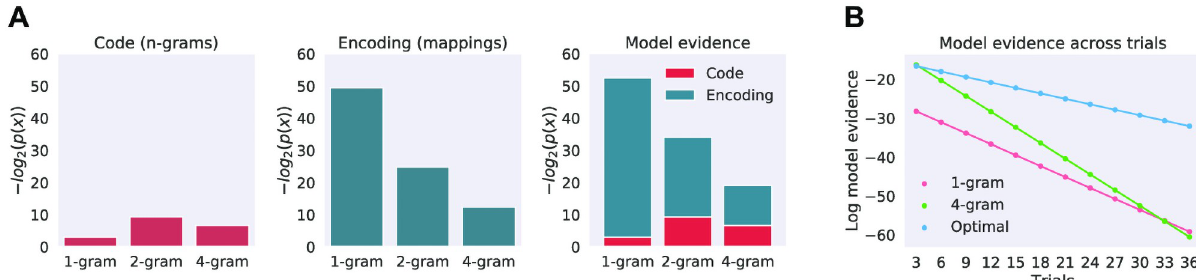
Fig 8. Optimal chunking model. (A) Evidence for three alternative chunking models and their components at the beginning of the scanning experiment, when participants had seen the two repeating sequences 12 times each during the practice session. The three models use only single type n- grams: the 1-gram model encodes sequences using four single-item n-grams, 2-gram model with two bi-grams, and the 4-gram model with a single four-gram. The left panel shows the probability of the set of n-grams (code) each model specifies in terms of their negative log values. The centre panel shows the probability of their mappings (encoding) and the right panel the combination of the two into model evidence. The blue and red parts of the model evidence bar represent model code (n-grams) and encoding (mappings) probabilities in terms of their negative logs and the total length of the bar displays the model evidence as their sum. This allows intuitive visualisation of the code-encoding trade-off calculated by the Bayesian model comparison. The 4-gram model is the optimal model at the start of the experiment. (B) Model evidence across trials. X-axis shows the trial number and y-axis shows the log of model evidence. The optimal model is inferred at every trial; the 1-gram model encodes sequences only with four uni-grams, and the 4-gram model only uses four-grams. Note that at the beginning of the experiment the 4-gram model is equivalent to the optimal model: however, as new sequences are presented the optimal model encodes new data with shorter chunks (uni-grams) while the 4-gram model encodes new unique sequences with four-grams. Note that as new data is observed the evidence for any particular model decreases as the set of data becomes larger and the space of possible models increases exponentially. Also note that the log scale transforms the change of evidence over trials into linear form.